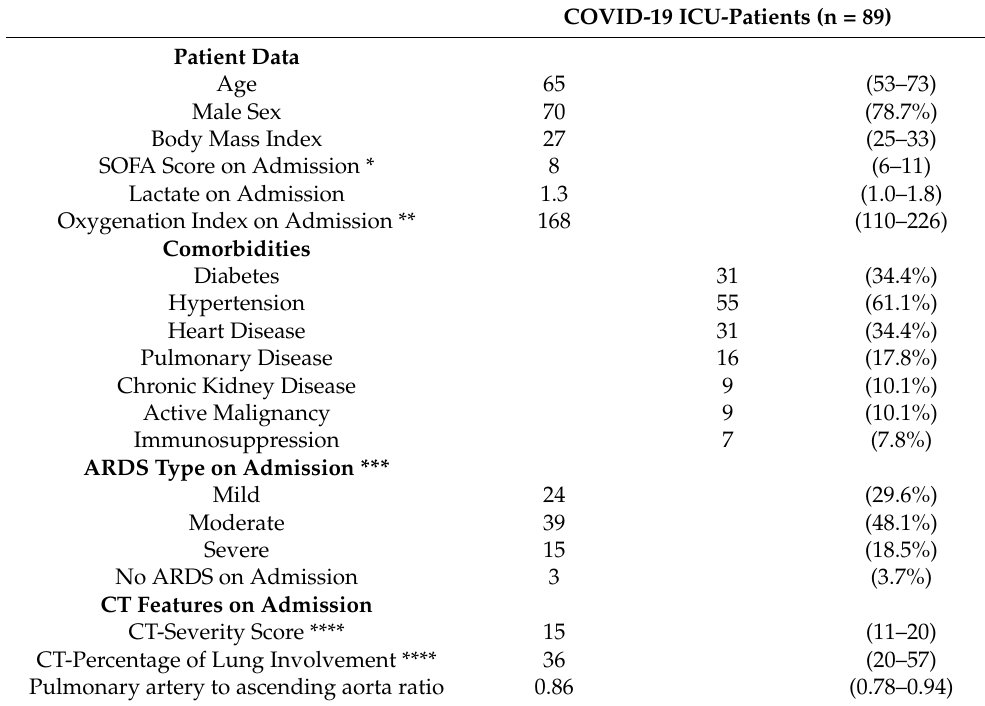
Table 1. Baseline characteristics of COVID-19 study patients admitted to the participating ICUs. Values presented are count (percentage) for categorical and median (interquartile range) for ordinal or continuous variables. COVID-19, Coronavirus disease 2019; ICU, intensive care unit; SOFA score, sequential organ failure assessment score; ARDS, acute respiratory distress syndrome; and CT, computed tomography; * 4 missing values; ** 9 missing values. *** 8 missing values. **** 10 missing